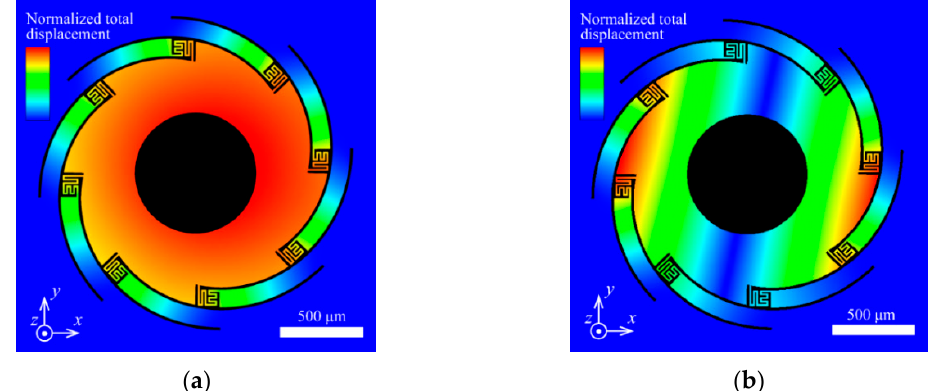
Figure 4. Modal simulation of the MEMS scanner: ( a ) first resonant mode, vertical piston, 1.4 kHz; ( b ) second resonant mode, lateral tilt, 1.8 kHz.